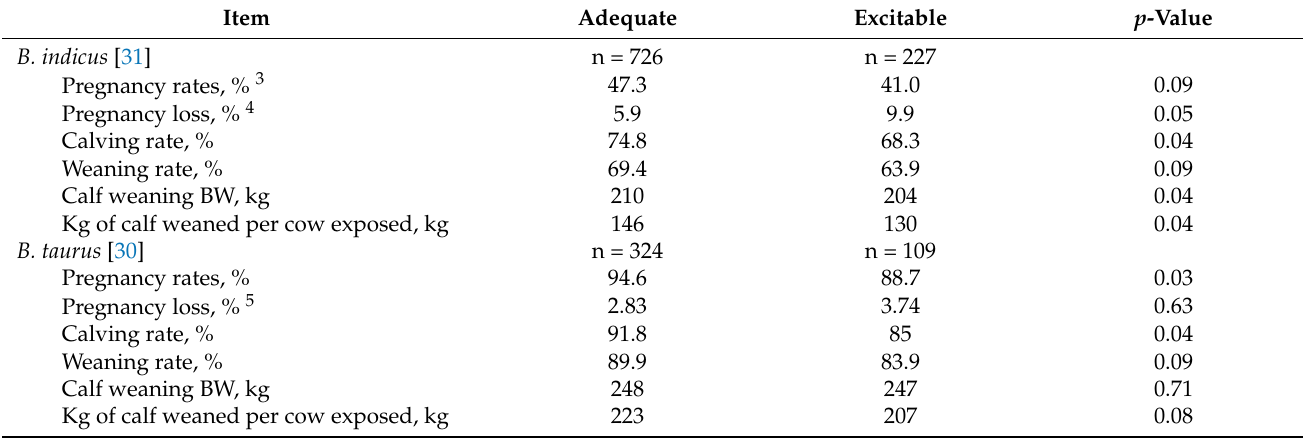
Table 2. Productive and reproductive variables evaluated in B. indicus and B. taurus cows in two separate studies. In both studies cows were classified according to their temperament type into adequate (temperament score 1,2 ≤ 3) or excitable (temperament score 1,2 > 3), utilizing chute score, and exit